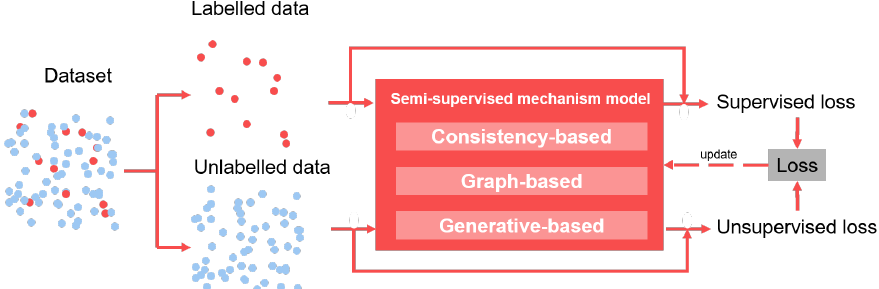
Figure 13. Data augmentation-based methods.